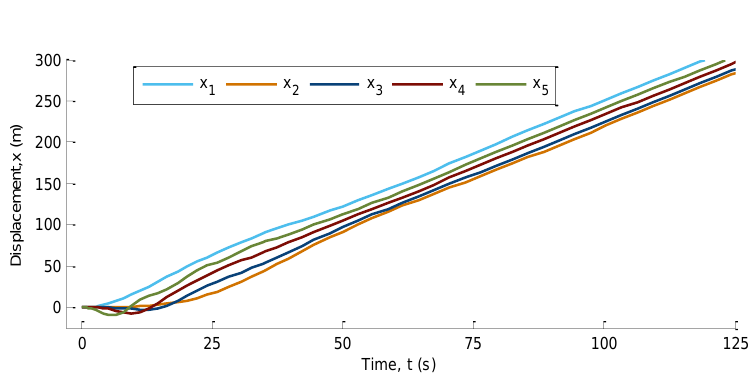
Figure 4. Velocity curves (Case 1)